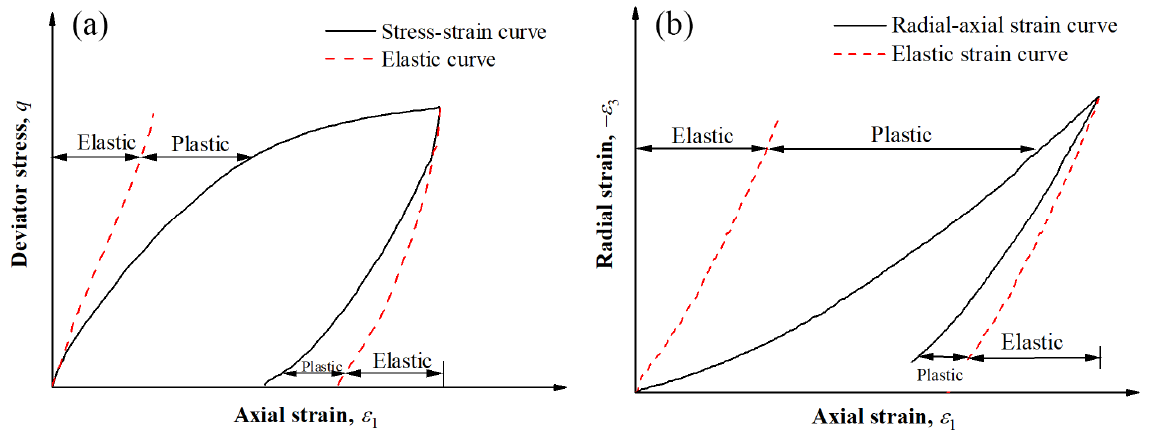
Figure 1. Sketch of the elastic strain extension domain and plastic strain extension domain during one cycle in ( a ) stress–strain relation and ( b ) radial–axial strain